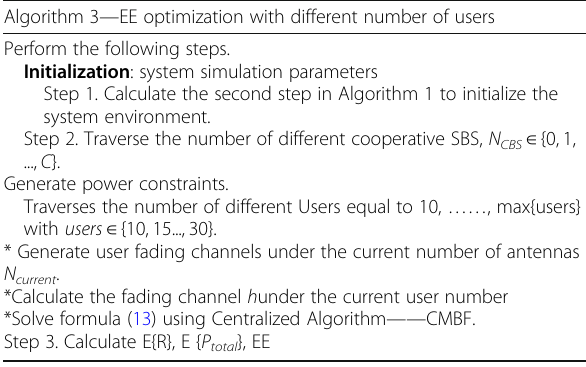
Table 4 EE optimization with different number of users Algorithm 3 — EE optimization with different number of